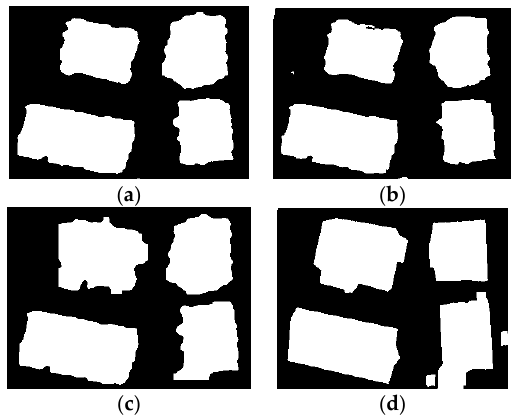
Figure 11. Segmentation results of four buildings by different methods. ( a ) Level-Set; ( b ) ORTSEG; ( c ) LS-ORTSEG; ( d ) Ground Truths. The ‘Hist.wSize’ is set to 3 for both ORTSEG and LS-ORTSEG.